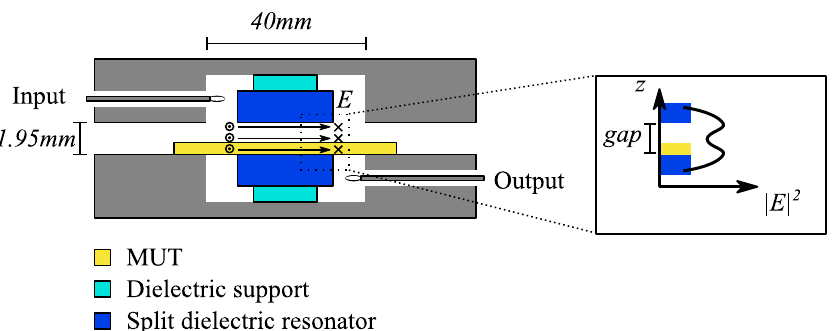
Figure 1. Sketch of the split-post dielectric resonator measurement setup. The MUT is placed in a gap, which separates the dielectric resonator. The electric field in this gap is strong, therefore, the device is sensitive to a change of dielectric constant introduced by the MUT. The change of the field strength along the gap inside the resonator is displayed as well. The E-field is strongest at the edges of the gap close to the resonator and weakest in the center of the gap.